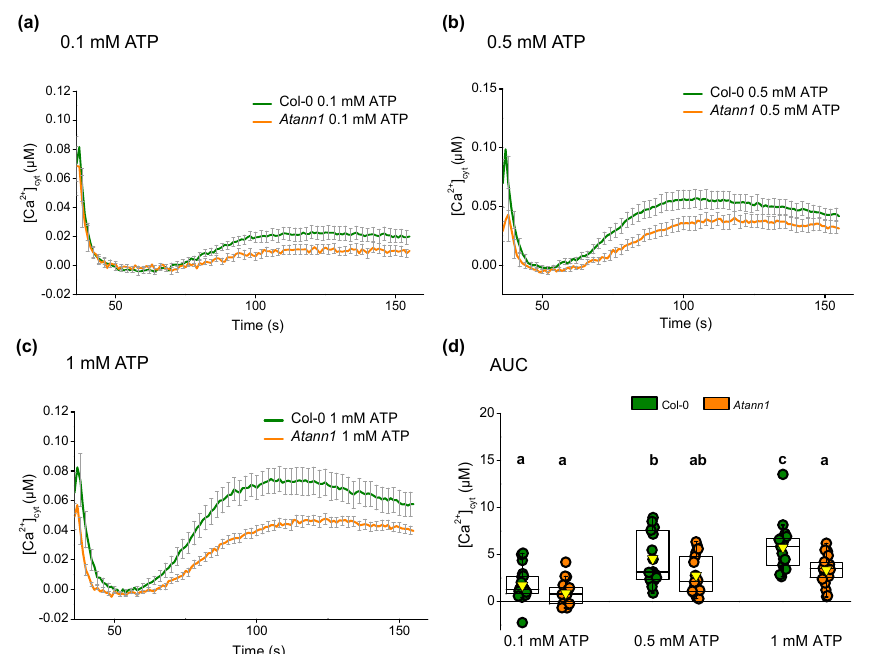
Figure 9. AtANN1 is required for leaf [Ca 2+ ] cyt elevation at higher concentrations of eATP. Mean (± SEM) [Ca 2+ ] cyt time course (t = 36 s–155 s) of 14-day-old individual true leaves treated with ( a ) 0.1 mM eATP, ( b ) 0.5 mM eATP or ( c ) 1 mM eATP. ( d ) The total [Ca 2+ ] cyt accumulated over the period of measurement for each concentration given as AUC. Data were obtained from four experiments with n = 17–22 per genotype and treatment. Middle line of the boxplot represents the median whereas the inverted triangle represents the mean. p -values were obtained from ANOVA with Tukey’s post-hoc test. Different lower-case letters indicate a significant difference between means ( p < 0.05).